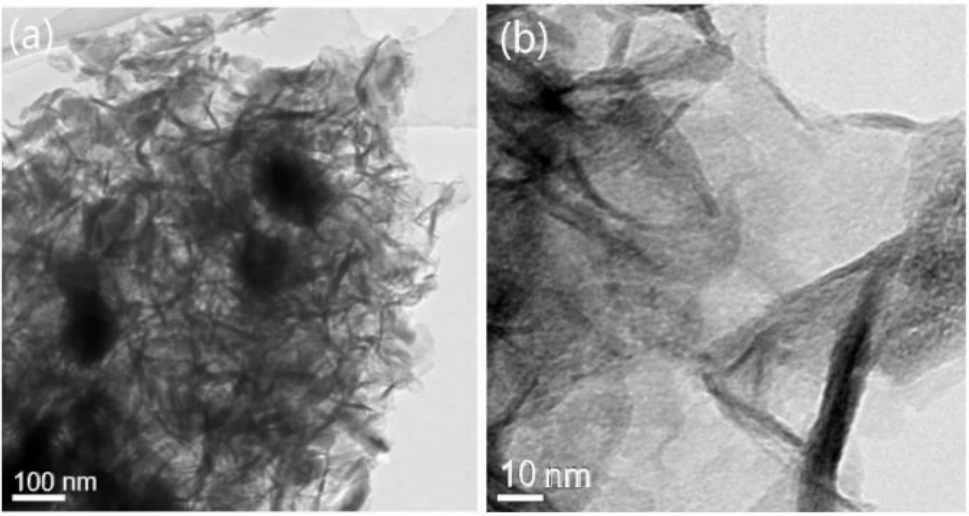
Figure 3. TEM images of Co-Cu t = 65°C catalyst ( a ) lager-scale image ( b ) small-scale image.